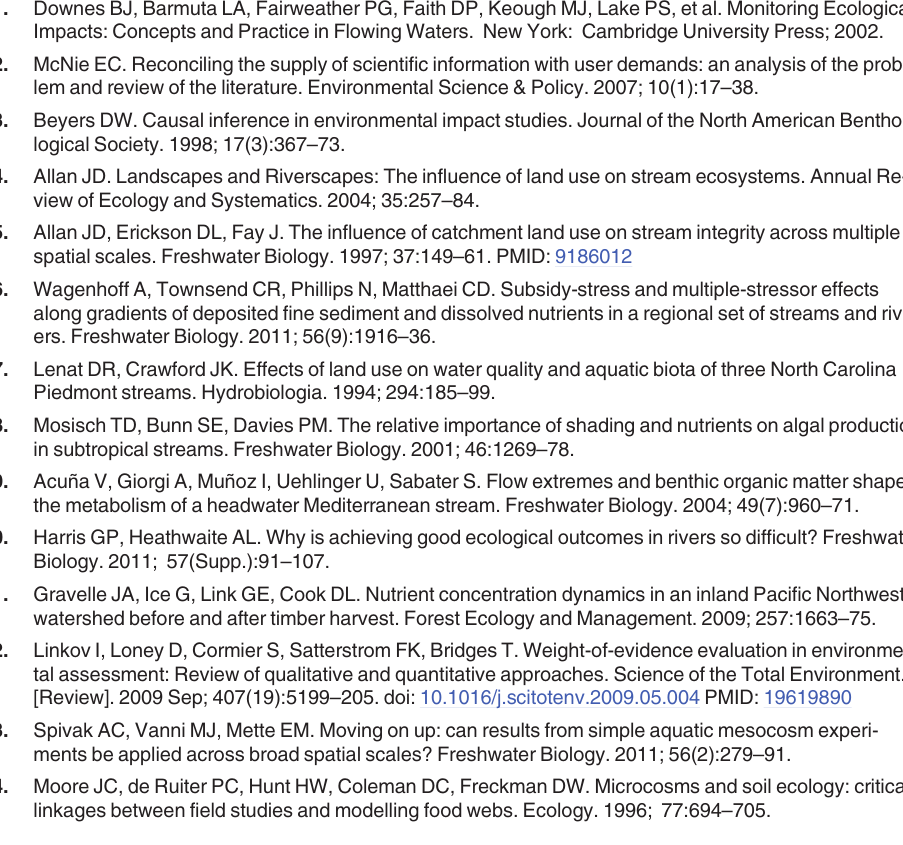
S1 Table. List of 27 sites surveyed in the gradient study. S2 Table. List of land-use categories and abbreviations included in statistical analyses. De- scriptions include references to the equivalent Australian Land-use and Management catego- ries (ALUM; BRS